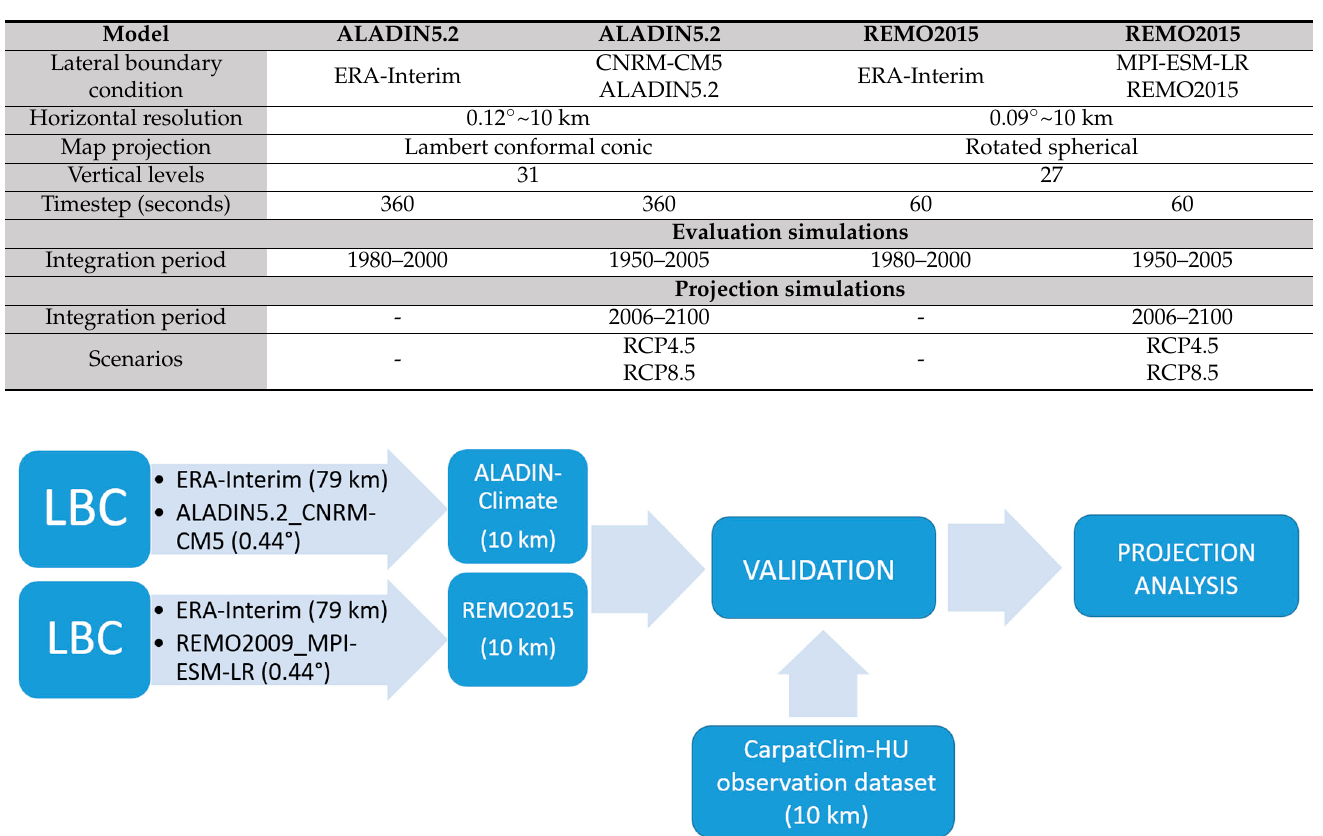
Table 2. Characteristics of the model experiments.